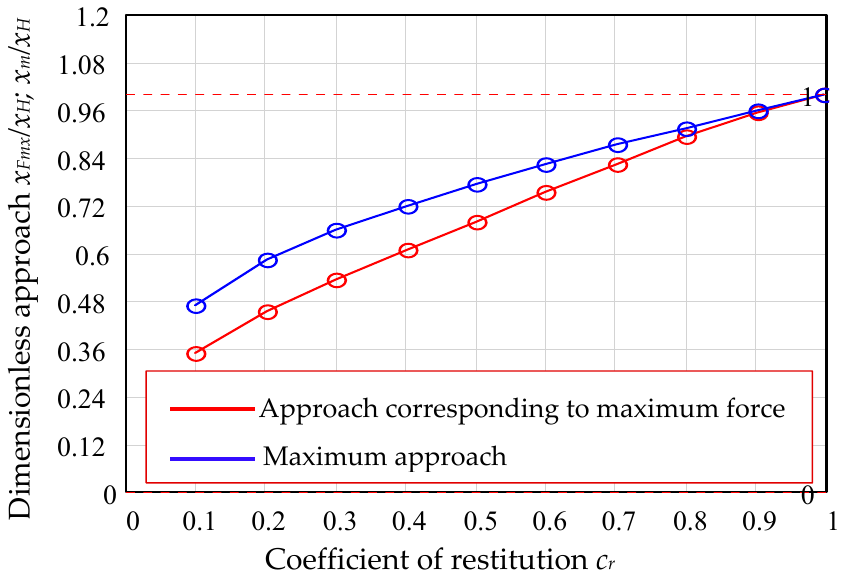
Figure 28. Dependency of the maximum approach ( x m ) and of the approach corresponding to maximum force ( x Fmx ) on coefficient of restitution ( c r ) .